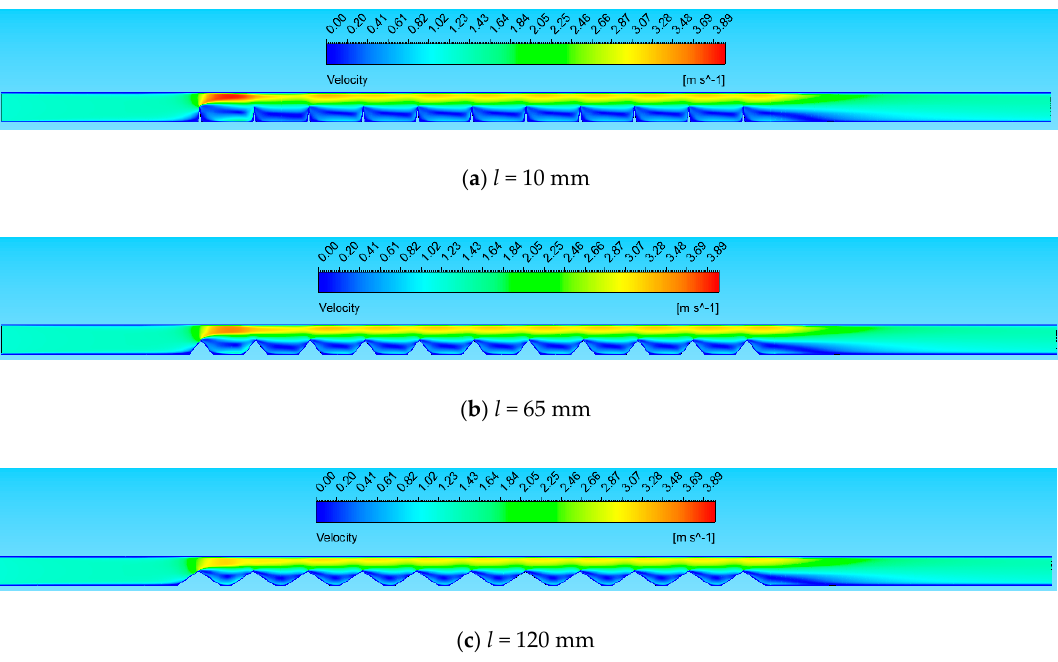
Figure 8. Velocity contours at Reynolds number of 12,000 for a fixed value of pitch ( P = 150 mm) and length ( l = 65 mm), and different value of height ( e ).